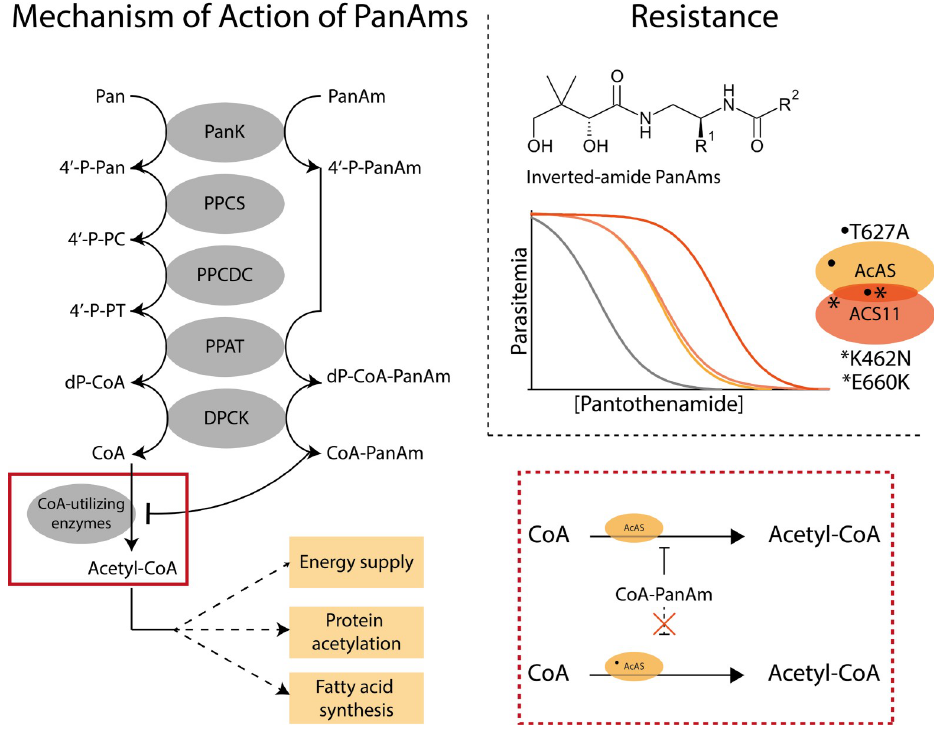
Fig 4. Mechanism of action of PanAms. PanAms are converted into CoA antimetabolites (CoA-PanAms) using 3 enzymes of the CoA pathway and reduce acetyl-CoA levels. Mutations in AcAS and ACS11 determine the resistance phenotype against iPanAms, which is indicated by the increased concentration of PanAms needed to kill parasites with mutations (yellow and orange lines) compared to wild-type parasites (gray line). Parasites are more resistant when both AcAS and ACS11 are mutated (dark orange line) than parasites with a single mutation in one of these enzymes (yellow and light orange lines). CoA-PanAm blocks the activity of the CoA-utilizing enzyme AcAS (red boxes), thereby reducing acetyl-CoA levels that may lead to downstream effects on protein modification or fatty acid metabolism in asexual blood stages. It is hypothesized that CoA-PanAm cannot bind to the mutated AcAS (dashed line), resulting in a normal level of acetyl-CoA. Whether ACS11 is a target of CoA-PanAm is still unknown. AcAS, acetyl-CoA synthetase; ACS11, acyl-CoA synthetase 11; CoA, coenzyme A; CoA-PanAm, pantothenamide CoA-analog; DPCK, dephospho- CoA kinase; dP-CoA, dephospho-CoA; dPCoA-PanAm, pantothenamide dephospho-CoA-analog; iPanAms, inverted- amide PanAms; Pan, pantothenate; PanAm, pantothenamide; PanK, pantothenate kinase; PPAT, phosphopantetheine adenylyltransferase; PPCDC, phosphopantothenoylcysteine decarboxylase; PPCS, phosphopantothenoylcysteine synthetase; 4 0 -P-Pan, 4 0 -phosphopantothenate; 4 0 P-PanAm, 4 0 -phosphopantothenamide; 4 0 -P-PC, 4 0 - phosphopantothenoyl-L-cysteine; 4 0 P-PT, pantetheine-4 0 -phosphate.